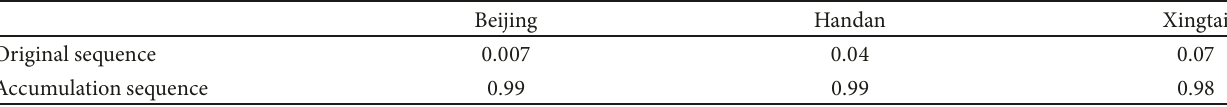
Table 2: The AQI Hurst exponent value of three cities.